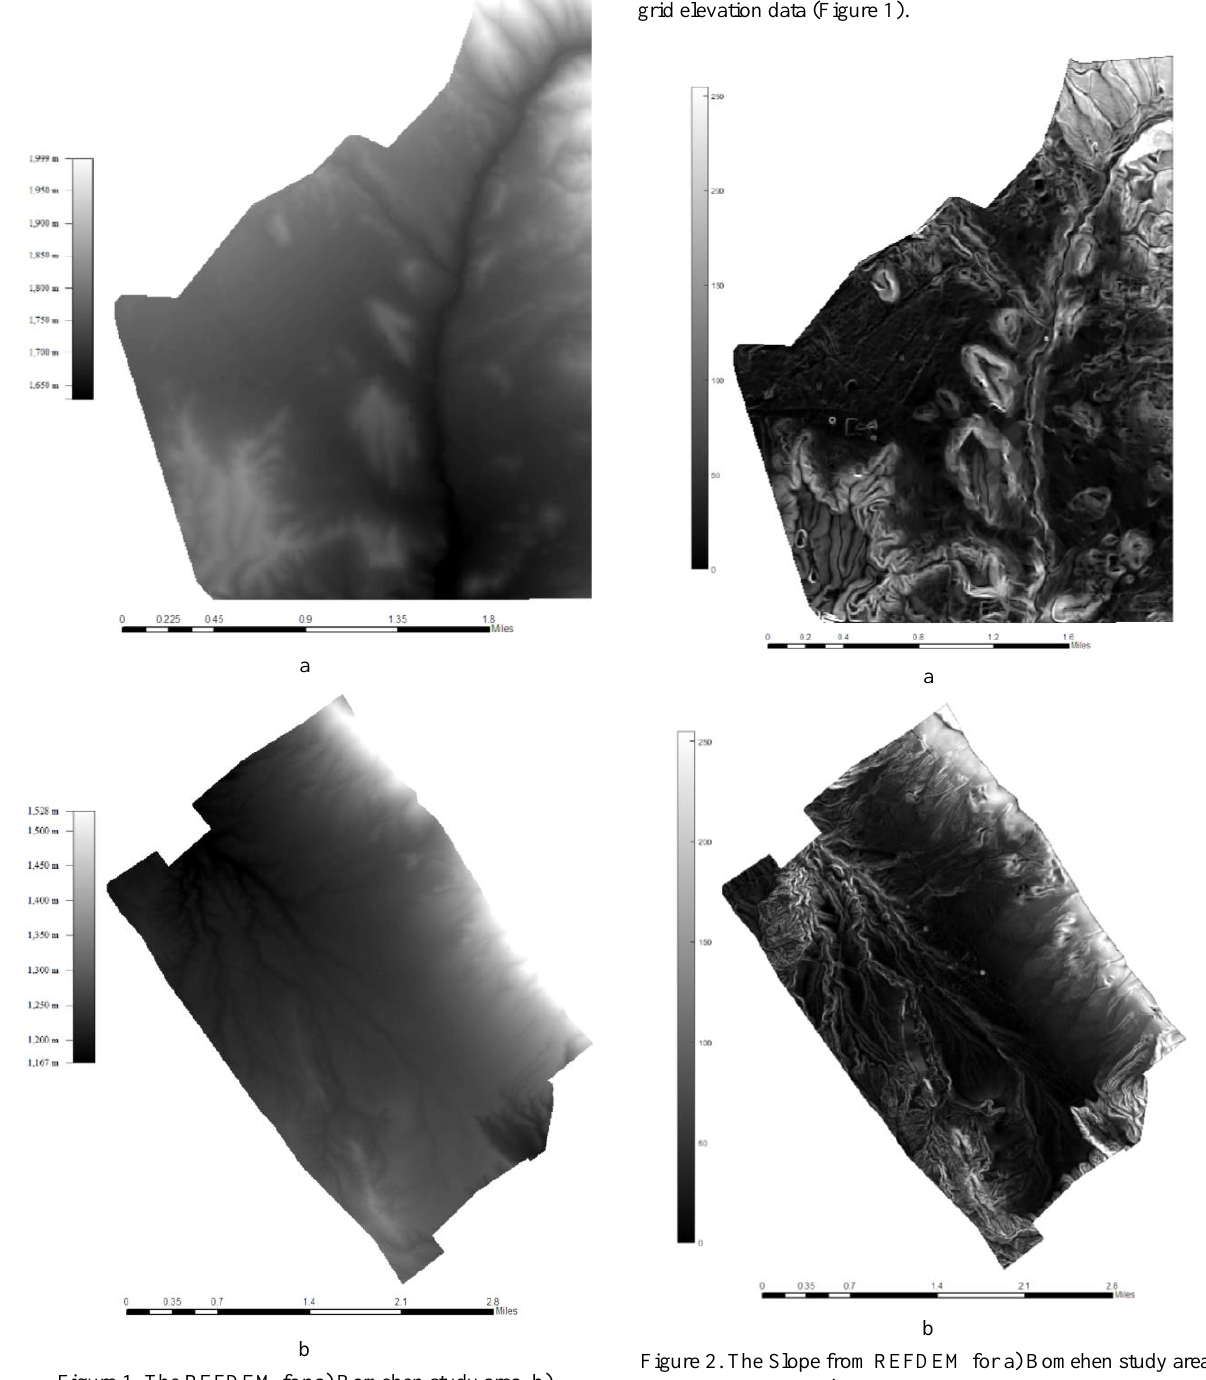
Figure 1. The REFDEM for a) Bomehen study area, b) Tazehabad study area